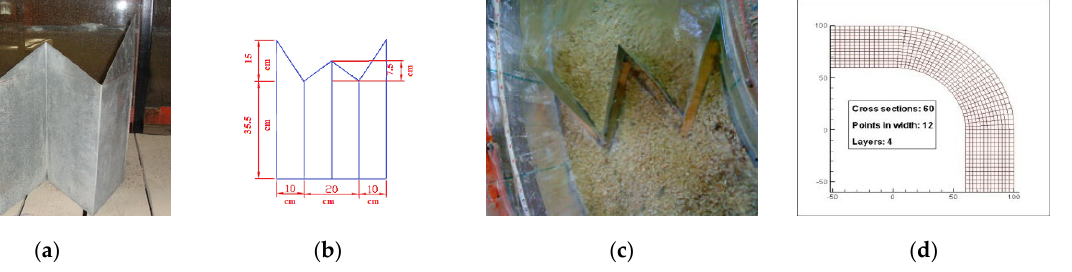
ent angles of the bend (Figure 3).